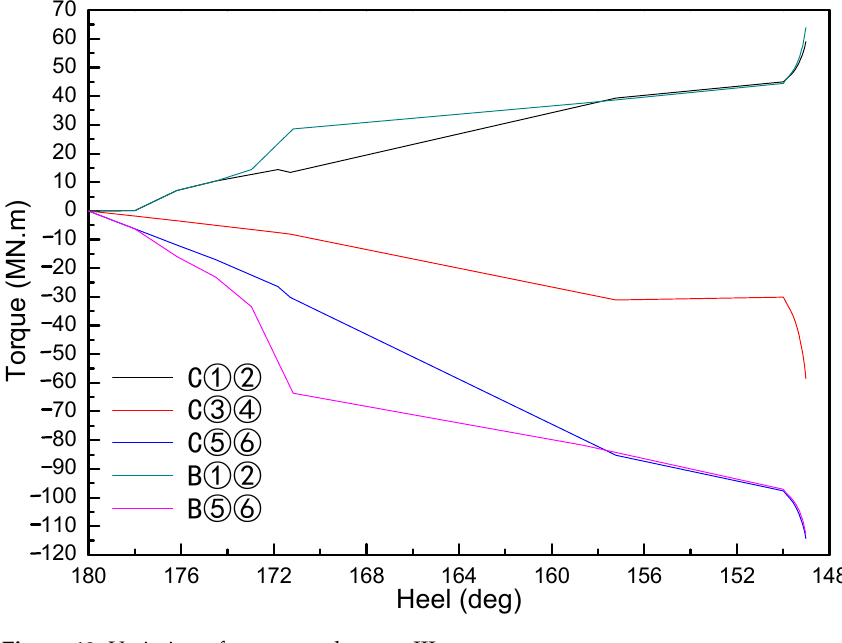
Figure 13. Variation of torque under case Ⅲ .